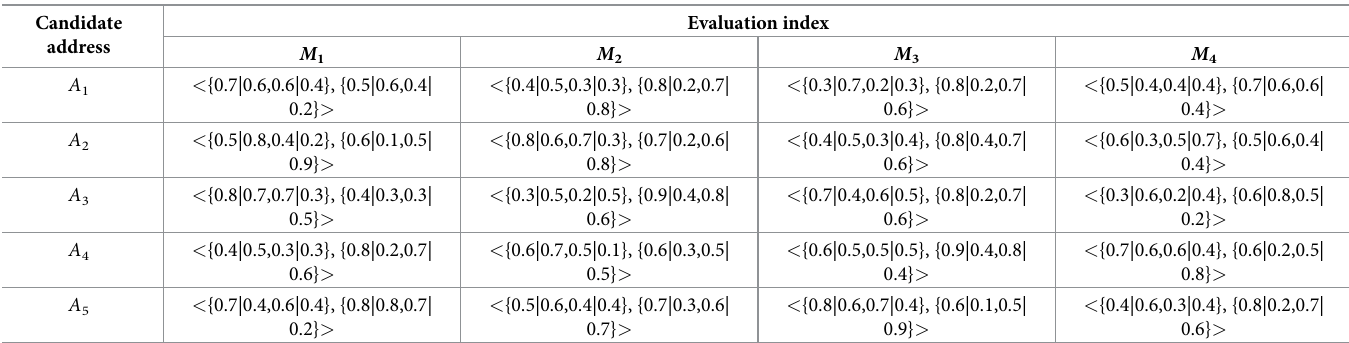
Table 1. The q-rung orthopair probabilistic hesitant fuzzy decision